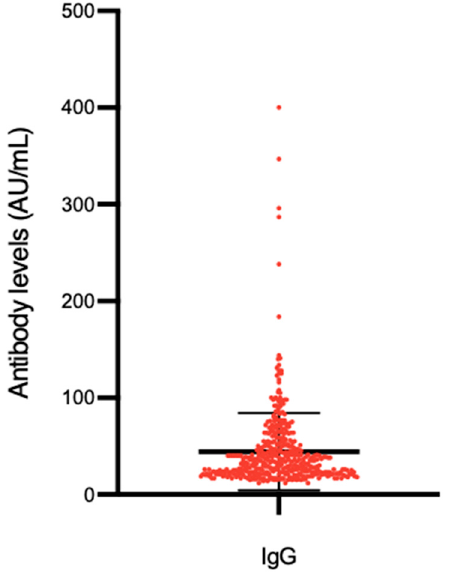
Figure 2. SARS-CoV-2 antibodies levels in seropositive participants ( n = 433). Two hundred and ninety HCWs had been previously diagnosed with SARS-CoV-2 infection by RT-PCR in the study period and 42 of them (14.5%) did not show a detectable antibody response.